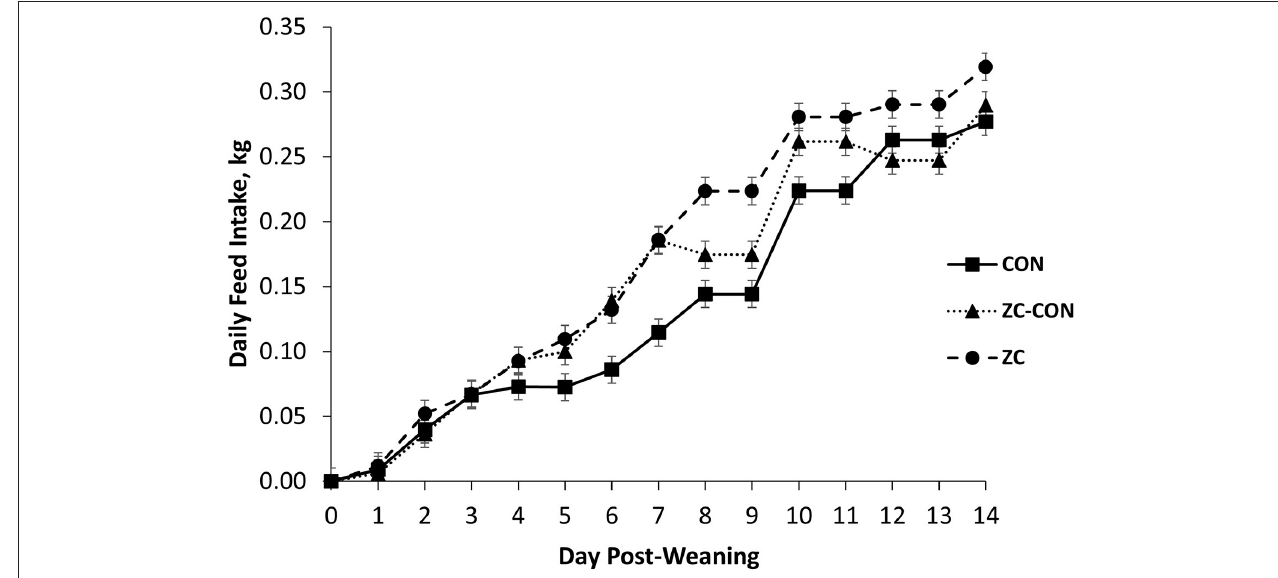
FIGURE 1 | Post-weaning daily feed intake in nursery pigs fed diets containing no pharmacological zinc or copper ( CON ), pharmacological zinc and copper ( ZC ) or phase 1 (day 0–7) diets containing pharmacological zinc and copper, and CON in phase 2 (day 8–14; ZC-Con ). Day P < 0.0001, Treatment P < 0.0001 and Day × Treatment P < 0.0001. n = 10